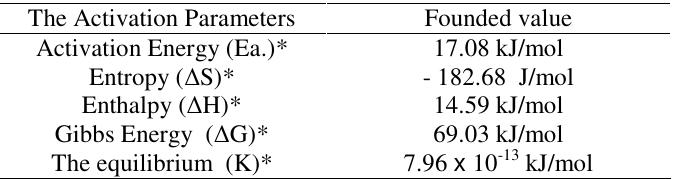
= 656 nm, 10% v\v ethanol, T = 36-64 o max